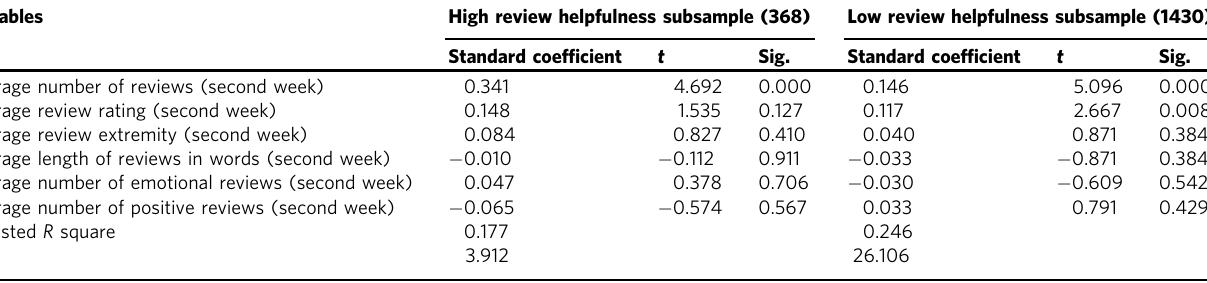
Table 5 Regression analysis for box of fi ce revenue for the third week after release using review helpfulness subsample. Variables